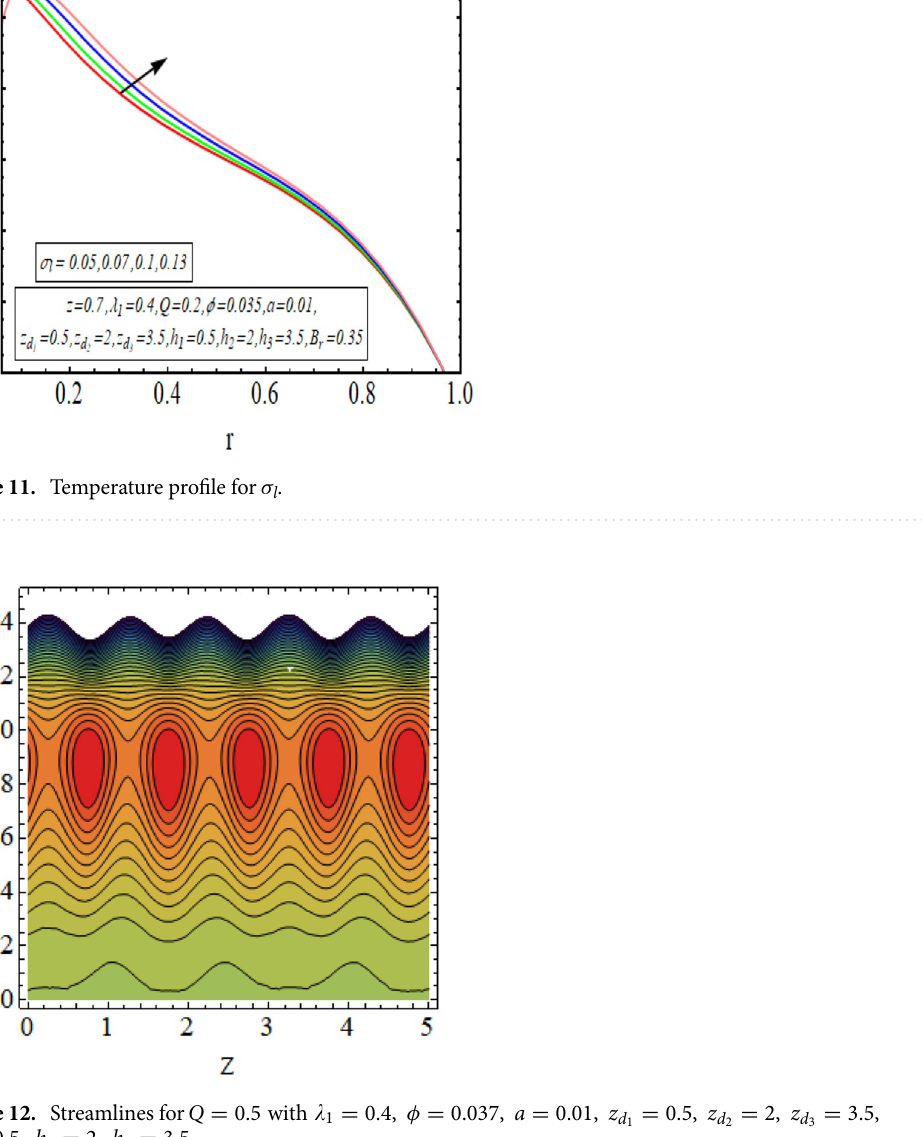
Figure 12. Streamlines for Q = 0.5 with (cid:31) 1 = 0.4, φ = 0.037, a = 0.01, z d 1 = 0.5, z d 2 = 2, z d 3 = 3.5, h 1 = 0.5, h 2 = 2, h 3 =